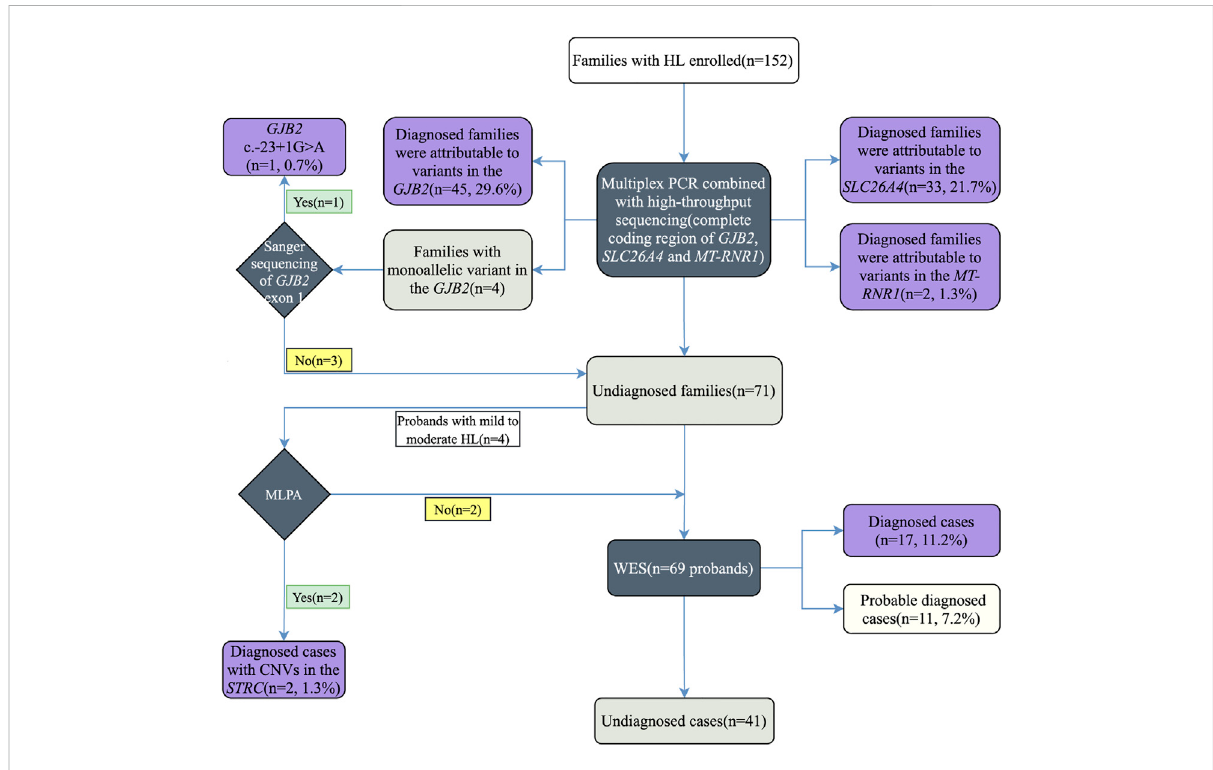
FIGURE 1 Study design and summary of stepwise genetic testing